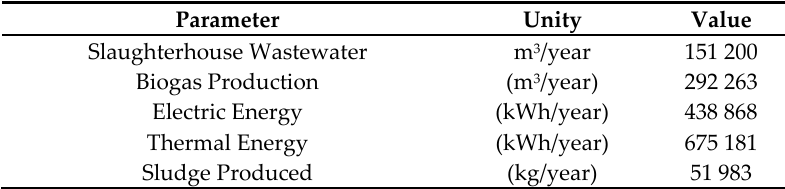
Table 1. Annual production of biogas, electric and liquid thermal energy in the anaerobic digestion unit and annual amount of effluent received and annual sludge